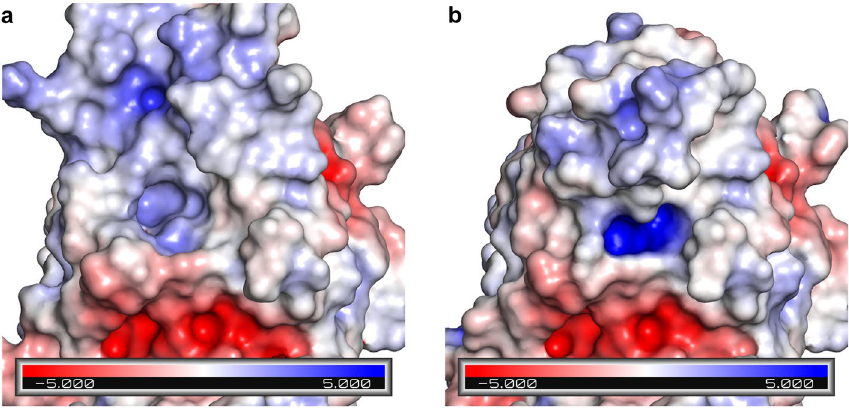
Figure 3. Electrostatic potential surface (EPS) of APO-EcAII (PDB ID: 6YZI) ( a ) and EcAII-ASP (PDB ID: 1NNS) ( b ). The focus is on the monomer N-terminal substrate binding pocket, central in each panel. Unit of measurement of electrostatic potential: